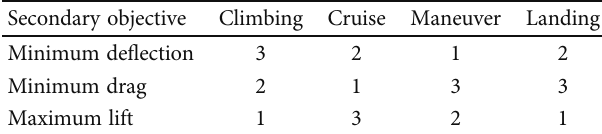
Table 3: Priority of each secondary